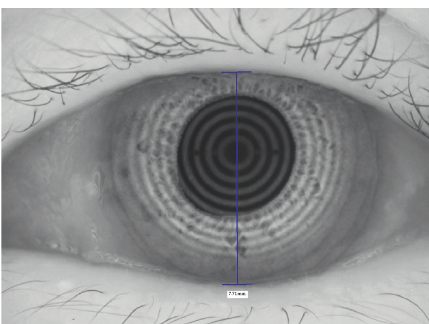
Figure 1: A diagrammatic description of the vertical fissure height measurement on the photograph captured by OCULUS Kerato- graph (the blue